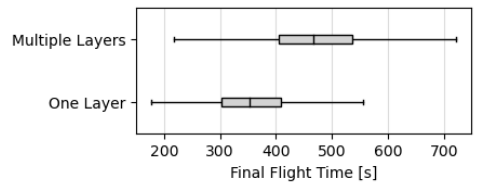
Figure 24. Flight time per aircraft without CR.